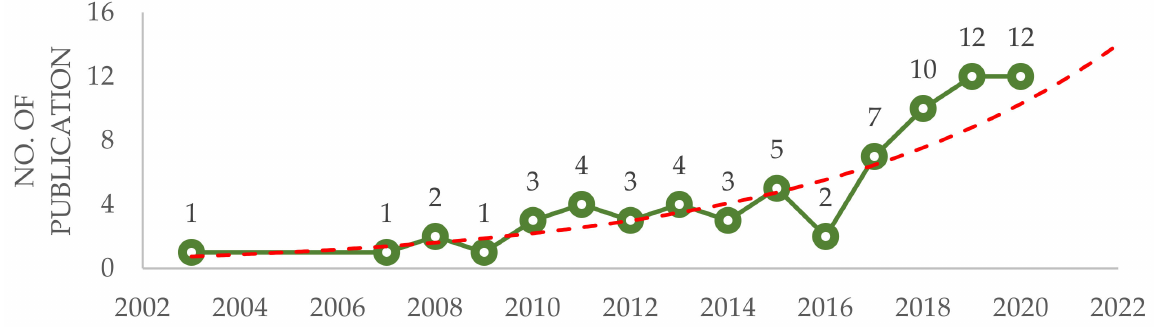
Figure 2. Temporal distribution and trend of SIAH